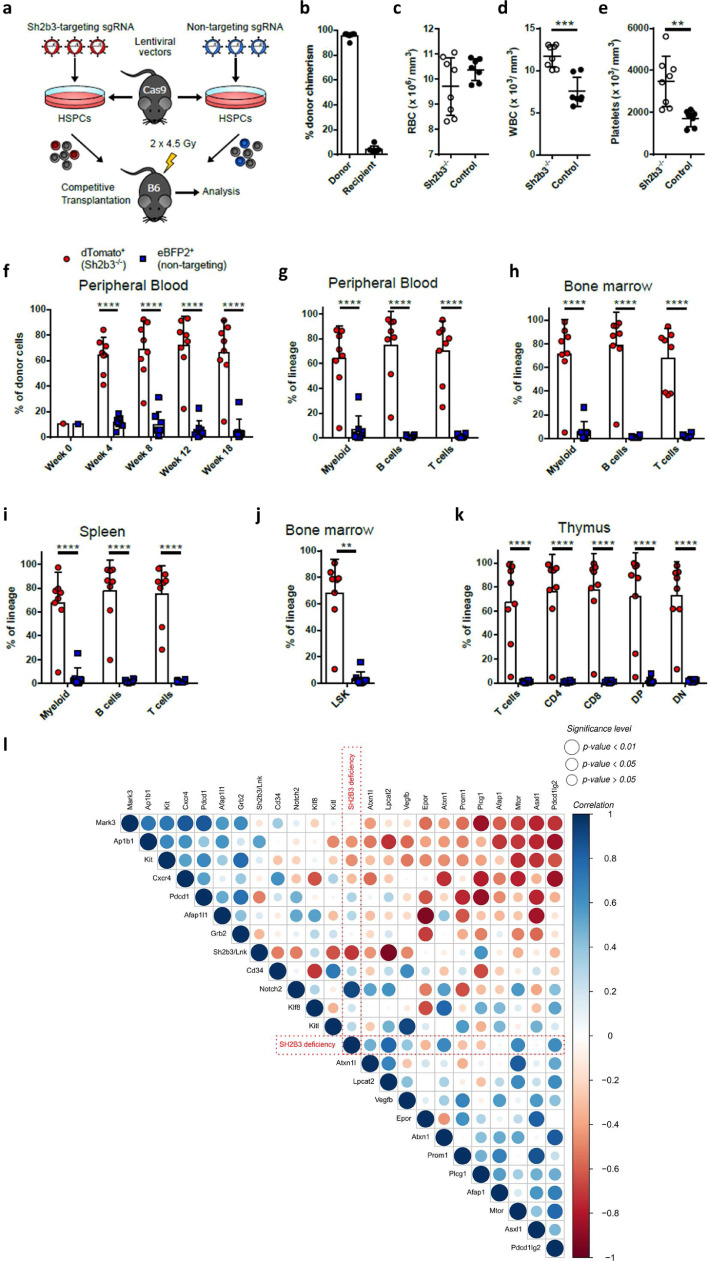
Influence of SH2B3 on HSC clonal overgrowth by using competitive bone marrow transplantation of Sh2b3−/− HSPCs. a: Scheme of the competitive transplantation assay is shown. HSPCs, which are derived from a SpCas9 transgenic mouse model (GFP+), were transduced with a lentiviral vector carrying a sgRNA against Sh2b3 and a dTomato fluorescent reporter. As competitor cells, HSPCs were transduced with a non-targeting sgRNA and an eBFP2 fluorescent reporter. After transduction, the Sh2b3−/− and Sh2b3-intact competitor cells were transplanted in a 1:1 mixture into irradiated C57BL/6 (B6, GFP−) recipient mice. Irradiation was performed using a fractionated dose of 2 × 4.5 Gy. b: Percentage of donor (GFP+) and recipient (GFP−) cells of total CD45+ cells in the bone marrow of mice at week 18 after transplantation. c: Red blood cell (RBC) count in Sh2b3−/− transplanted mice and untreated control animals at week 18 after transplantation. d: White blood cell (WBC) count in Sh2b3−/− transplanted mice and untreated control animals at week 18 after transplantation. e: Platelet count in Sh2b3−/− transplanted mice and untreated control animals at week 18 after transplantation. f: Presence of Sh2b3−/- (dTomato+) and competitor (eBFP2+) cells in the donor cell population in the peripheral blood at week 4, 8, 12, and 18 after transplantation. Week 0 shows the presence of dTomato+ and eBFP2+ cells in the transplanted cell population. g-k: Presence of Sh2b3−/- (dTomato+) and Sh2b3-intact competitor (eBFP2+) cells in the indicated lineage of donor cells in the peripheral blood g:, in the bone marrow h:, in the spleen i:, in Lineage− Sca1+ cKIT+ (LSK) HSPCs of the bone marrow j:, and in T cells of the thymus k: at week 18 after transplantation. l: Pearson correlation analysis of RNA-Seq data derived from murine Sh2b3 HSC clonal overgrowth model. The Sh2b3 deficiency (red) is highlighted for an improved visual analysis of important correlations. The color scale, ranging from 1 to -1 in the upper panel (blue to red), represents the correlation between the different factors. The size of the dots represents the significance (p<0.01, p<0.05, and p>0.05, Pearson correlation) of the respective correlation. Transplanted mice: n=8. Control mice: n=7. All graphs represent mean ± SD. Statistics: c-e: Unpaired t-test after normality test (D'Agostino & Pearson omnibus normality test) was passed; f-i:, k: Two-way ANOVA. j: Kolmogorov-Smirnov test. Significance level: ** p<0. 01, *** p<0.001, and **** p<0.0001 (For interpretation of the references to color in this figure legend, the reader is referred to the web version of this article.).